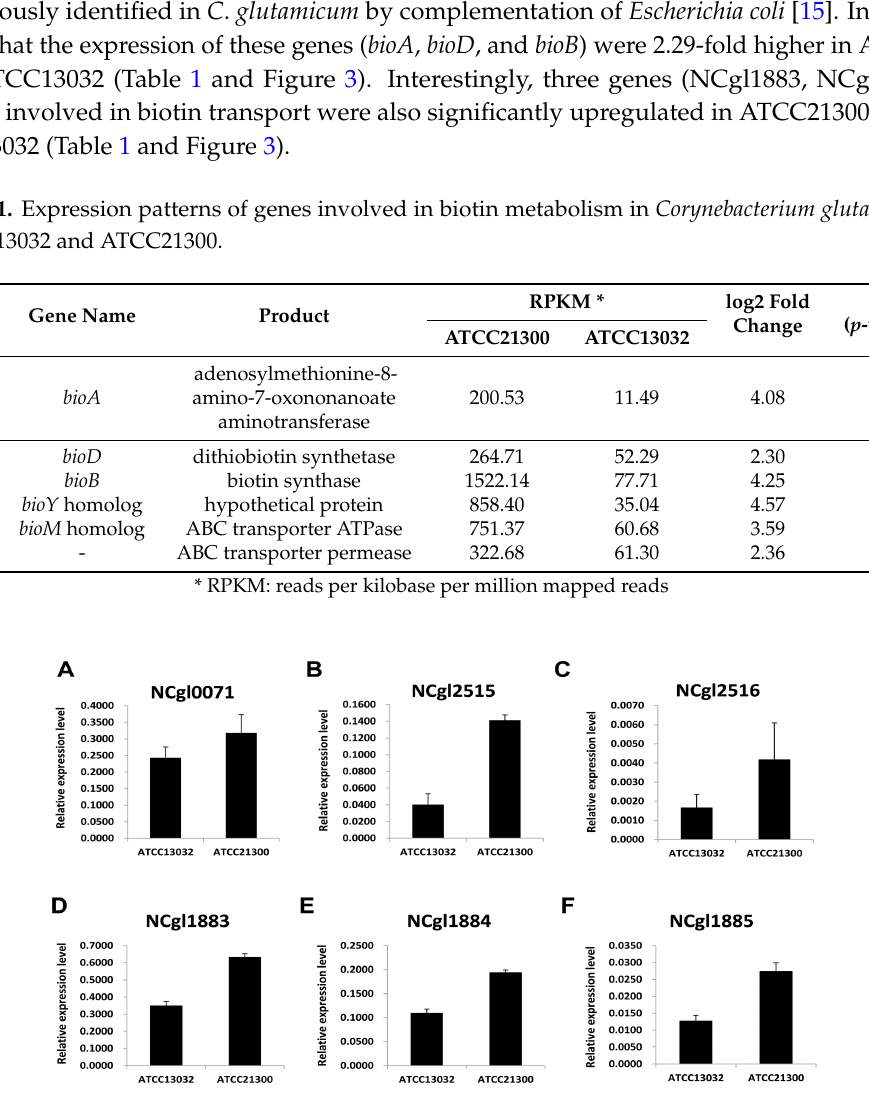
Figure 3. The expression patterns of genes associated with biotin synthesis and transport in Corynebacterium glutamicum ATCC13032 and ATCC21300. ( A ) The expression pattern of bioB ; ( B ) the expression pattern of bioA ; ( C ) the expression pattern of bioD ; ( D ) the expression pattern of the bioY homolog; ( E ) the expression pattern of the bioM homolog; and ( F ) the expression pattern of the ABC transporter permease. The gene expression level (arbitrary units) was normalized using the 16s RNA level as an internal reference. Gene expression levels were quantified by real-time RT-PCR.